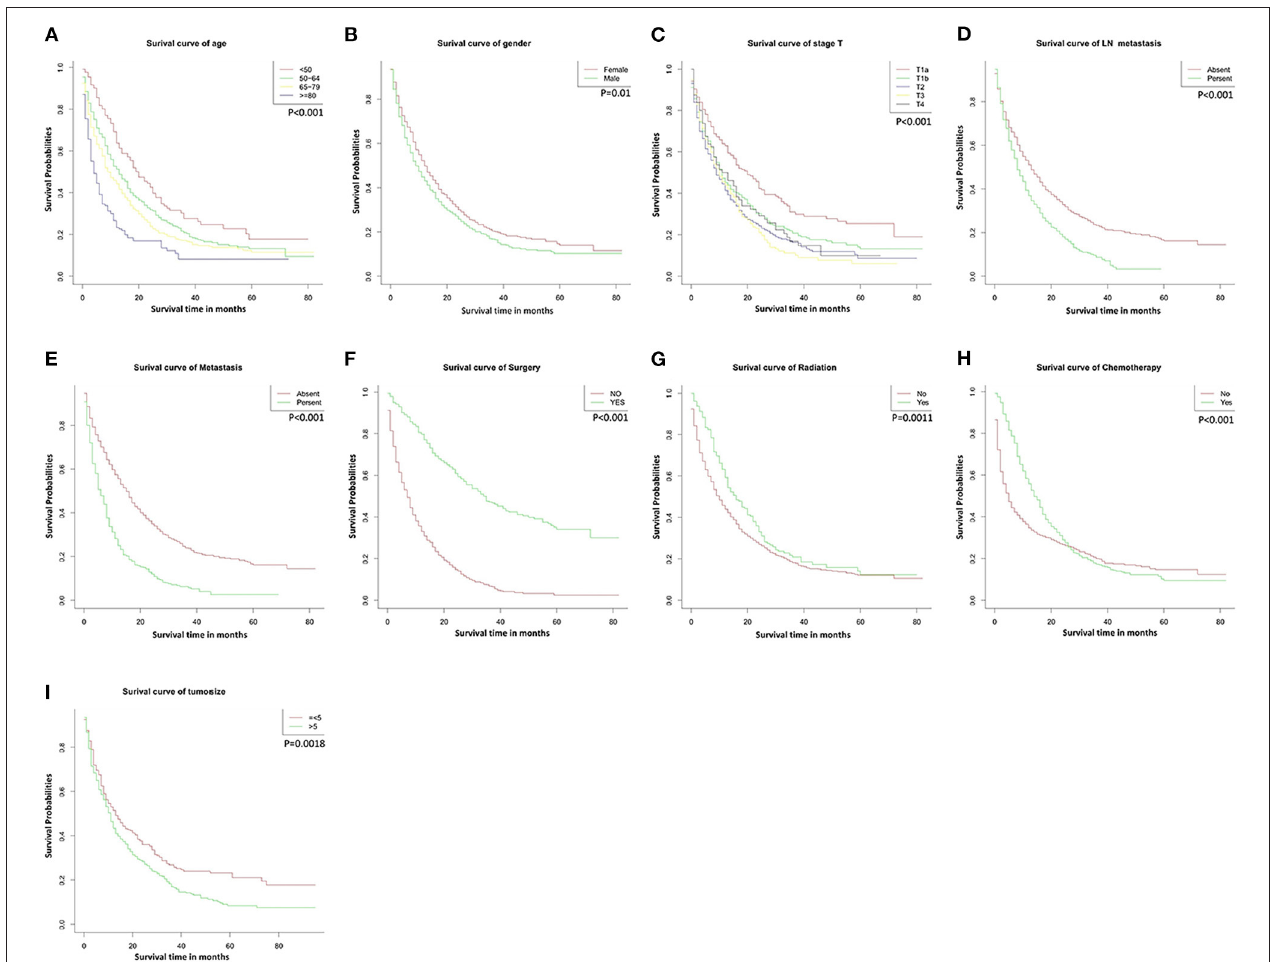
FIGURE 1 | Overall survival rates according to patient characteristics: (A) Age; (B) Gender; (C) T stage; (D) LN metastasis; (E) Metastasis; (F) Surgery; (G) Radiation; (H) Chemotherapy; (I) Tumor size. LN, lymph node.